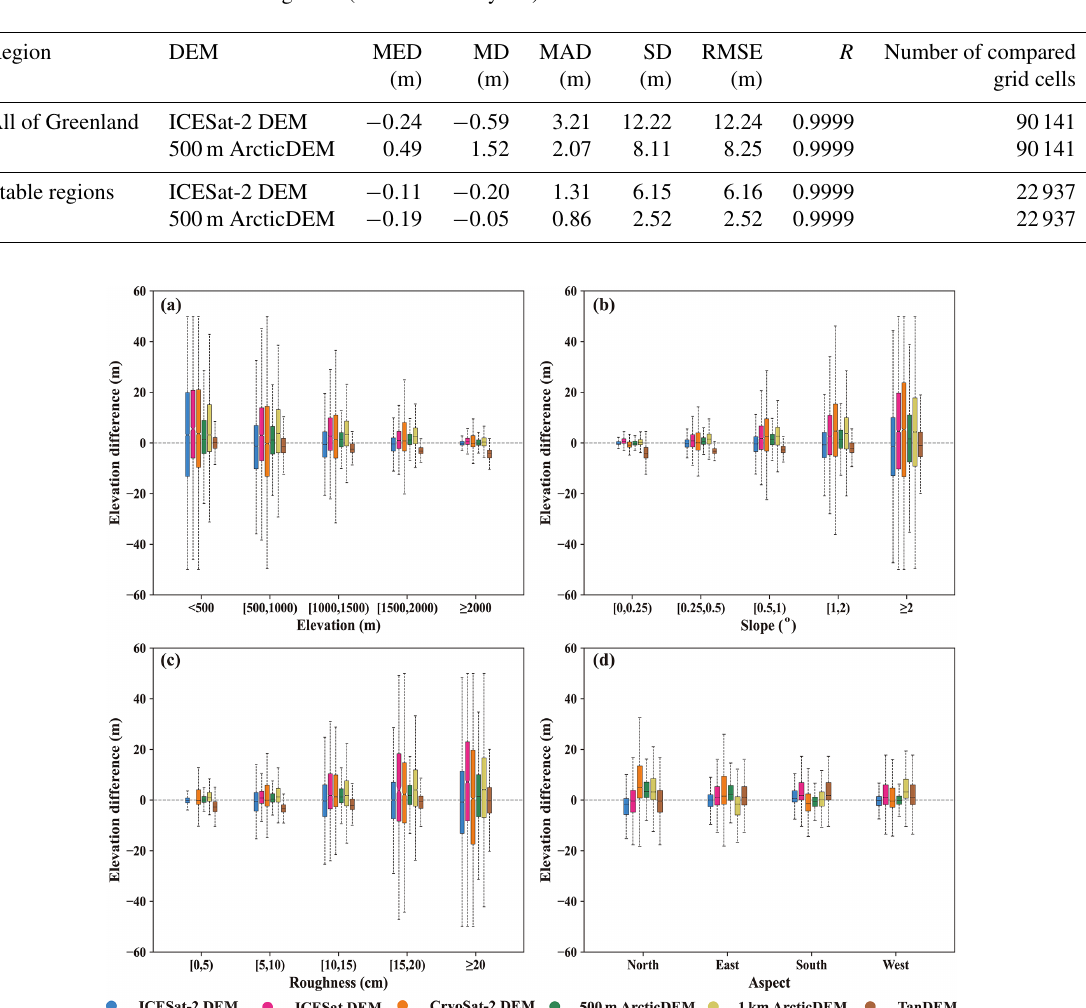
Figure 8. Elevation differences between different DEMs and IceBridge data under different terrain conditions: (a) elevation, (b) slope, (c) roughness, and (d) aspect. The solid black lines near the box centers denote median values of elevation differences, the upper and lower boundaries of each box denote upper and lower quartiles (Q1 and Q3), the length means the interquartile range (IQR), and the top and bottom lines denote the range [Q1–1.5 IQR–Q3 + 1.5